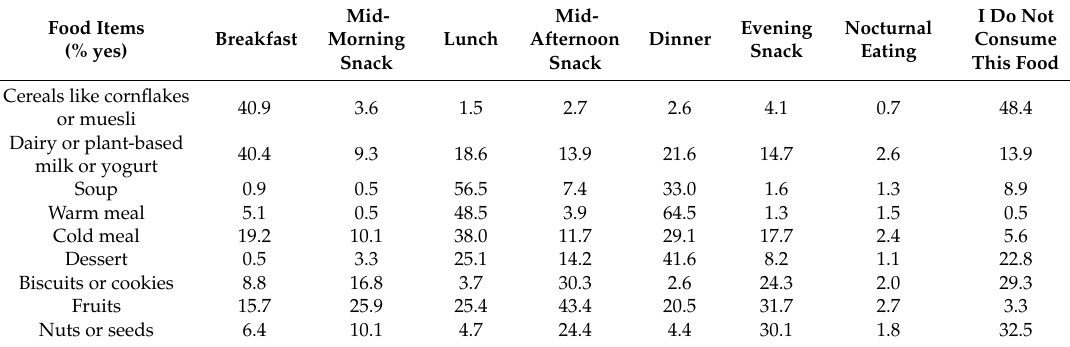
Table A1. Consumption pattern of 10 food items ( n =